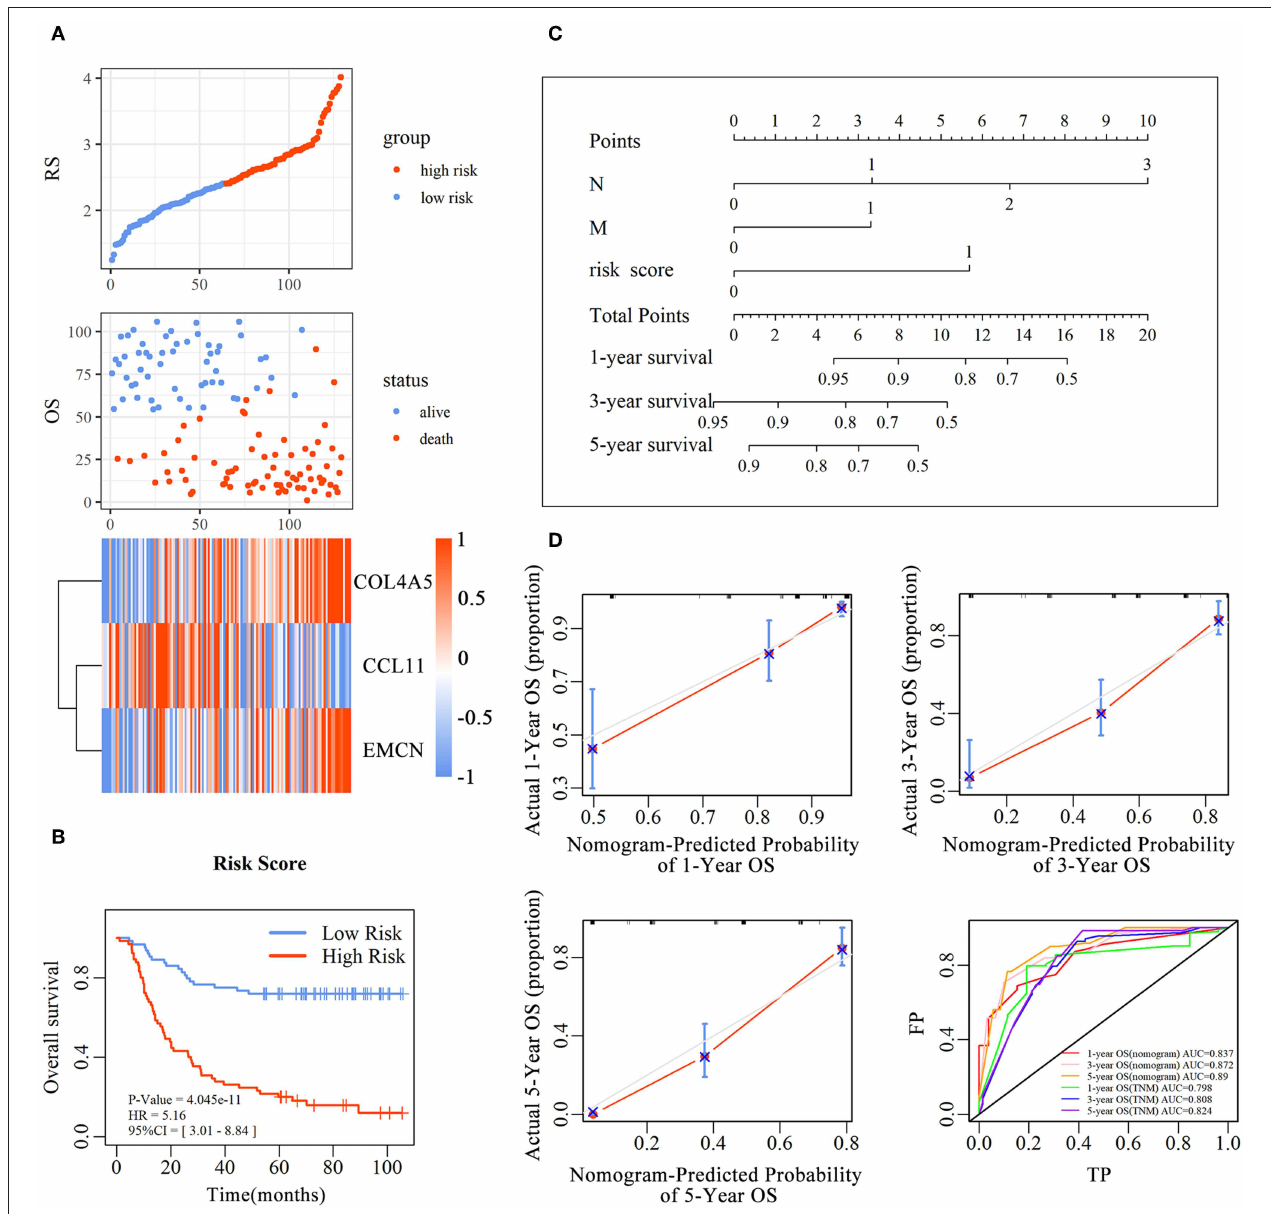
FIGURE 3 | The predictive value of the risk score for diffuse type GC. The association between RS and OS, survival status and the expression of genes in the 3-gene signature was showed in scatter and heatmap plot (A) . The pseudocolors on the right of heatmap plot represent expression levels from low to high on a scale from − 1 to 1, ranging from a low correlation power (white) to high (blue, or red). Kaplan–Meier was used to estimate the OS probability based on the RS in diffuse type GC, in which red plots indicates high-RS group, while the blue plot represents low-RS group (B) . Log-rank test was used to compare the survival distribution of these two groups. The nomogram was established with the RS, N-stage and M-stage in diffuse type GC (C) . The comparison between predicted and actual outcome for 1-, 3-, and 5-year survival probabilities in the nomogram was showed in the Calibration plots. Receiver operating characteristic (ROC) curves was used to compare the predictive ability of nomogram model and TNM stage for 1-, 3-, and 5-year survival probabilities (D) .